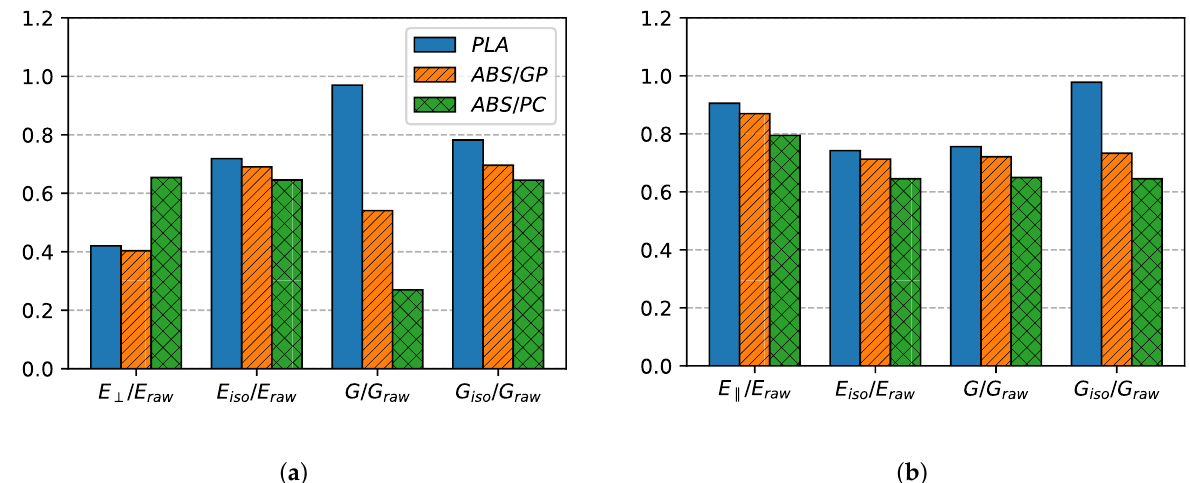
Figure 10. Non-dimensional relationships for PLA, ABS/GP, and ABS/PC referred to raw material properties. ( a ) Cover zone. ( b ) Contour zone.